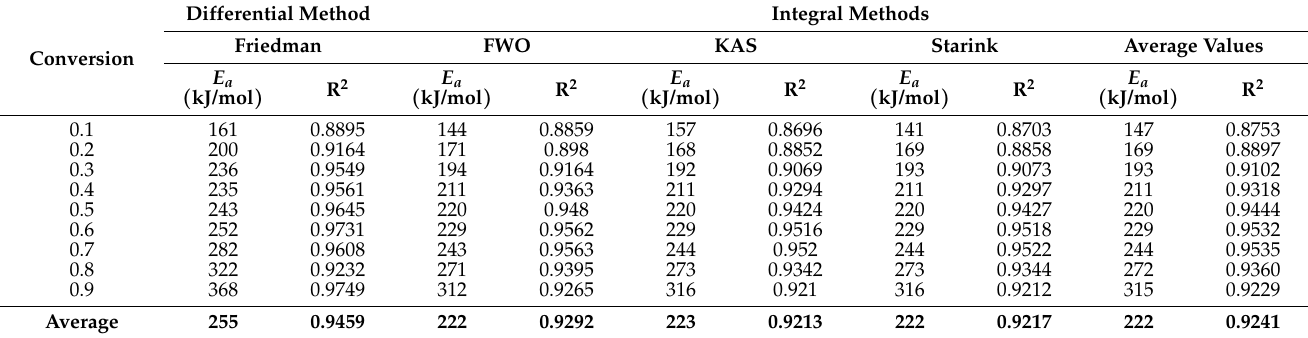
Table 6. Activation energy of the ternary mixtures of PP, PS, and LDPE obtained by different model-free